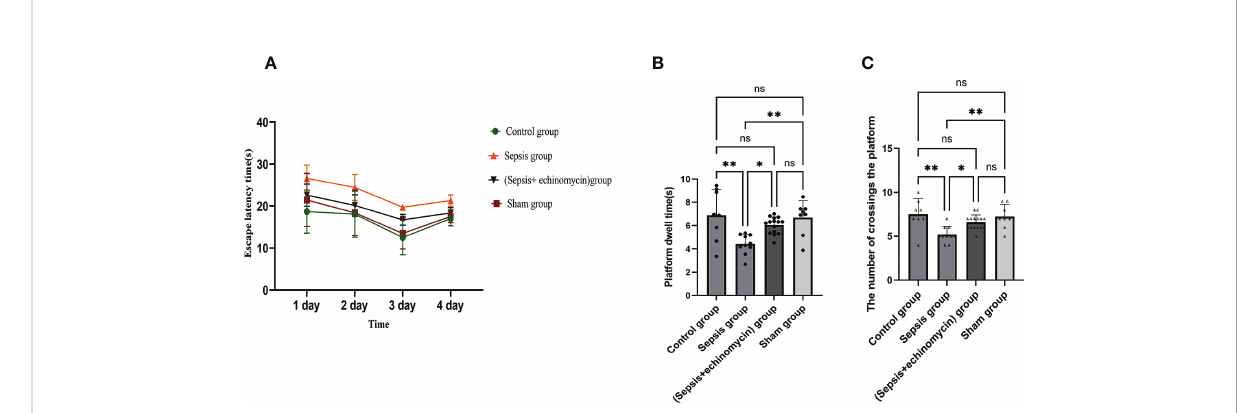
FIGURE 3 Echinomycin reversed CLP-induced learning and memory impairments. (A) :escape latency time. (B) :dwell target quadrant time. (C) :the number of crossings over the original platform area.*: p < 0.05, **: p < 0.01, ns: p > 0.05.